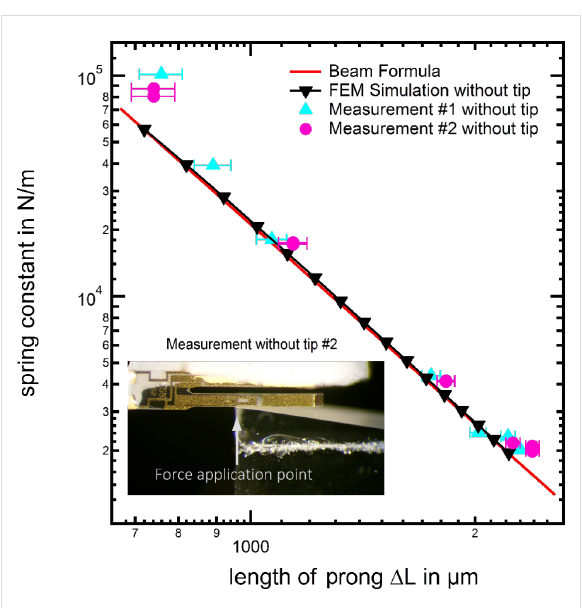
Figure 7: Comparison between the beam formula, experimental measurements and FEM simulation with the force directly applied to the tuning fork prong. The prior introduced origin shift has already been applied to the beam formula resulting in a higher compliance of the plot